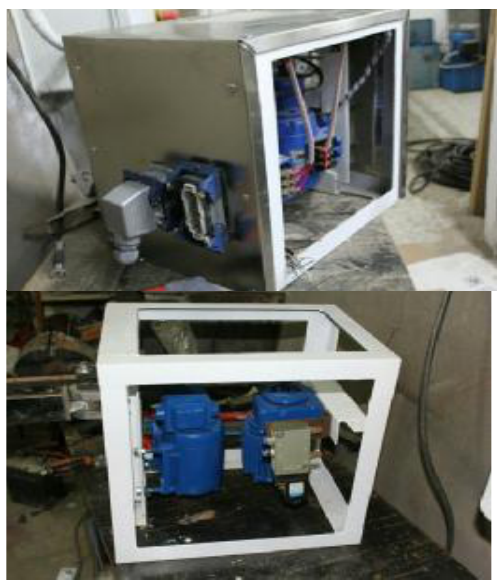
Fig. 8. Box From Iron and Covered by